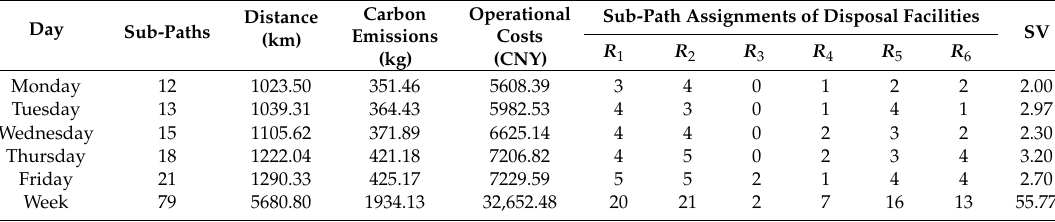
Figure 4. The optimal vehicle routes with minimized operational costs, carbon emissions, and penalty costs on Monday (model 2). Table 12. Results of model 1: Minimized operational costs and carbon